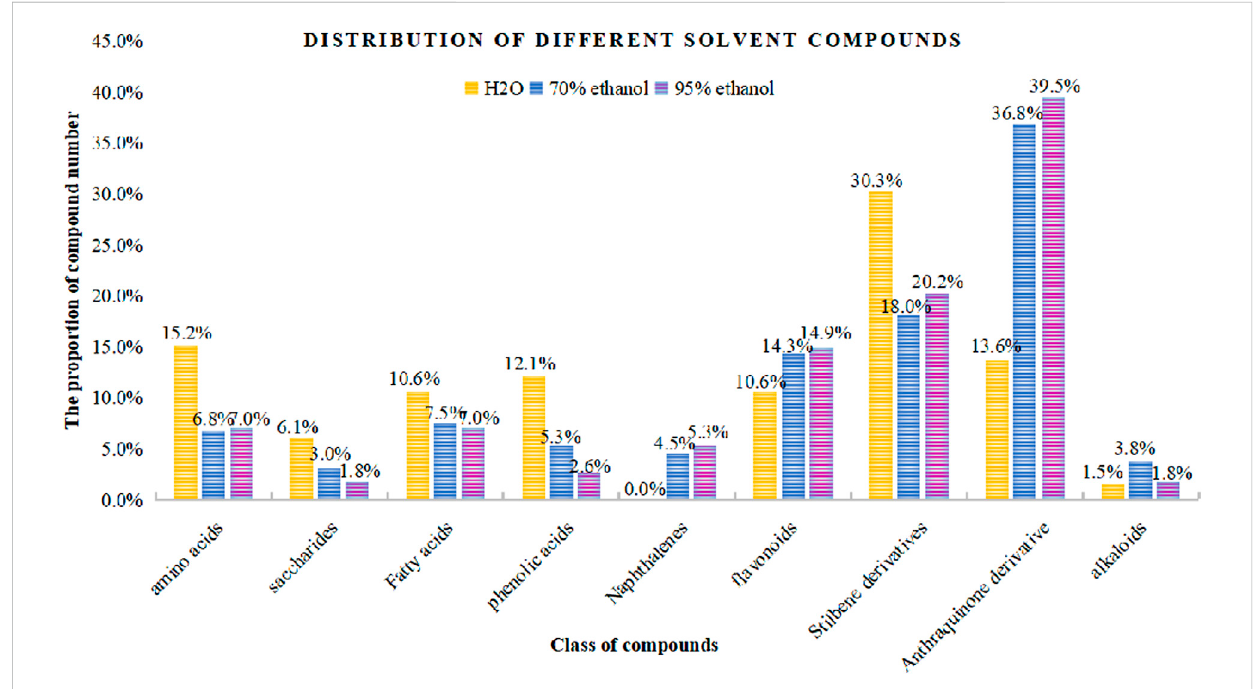
FIGURE 13 Distribution of compound amount in different